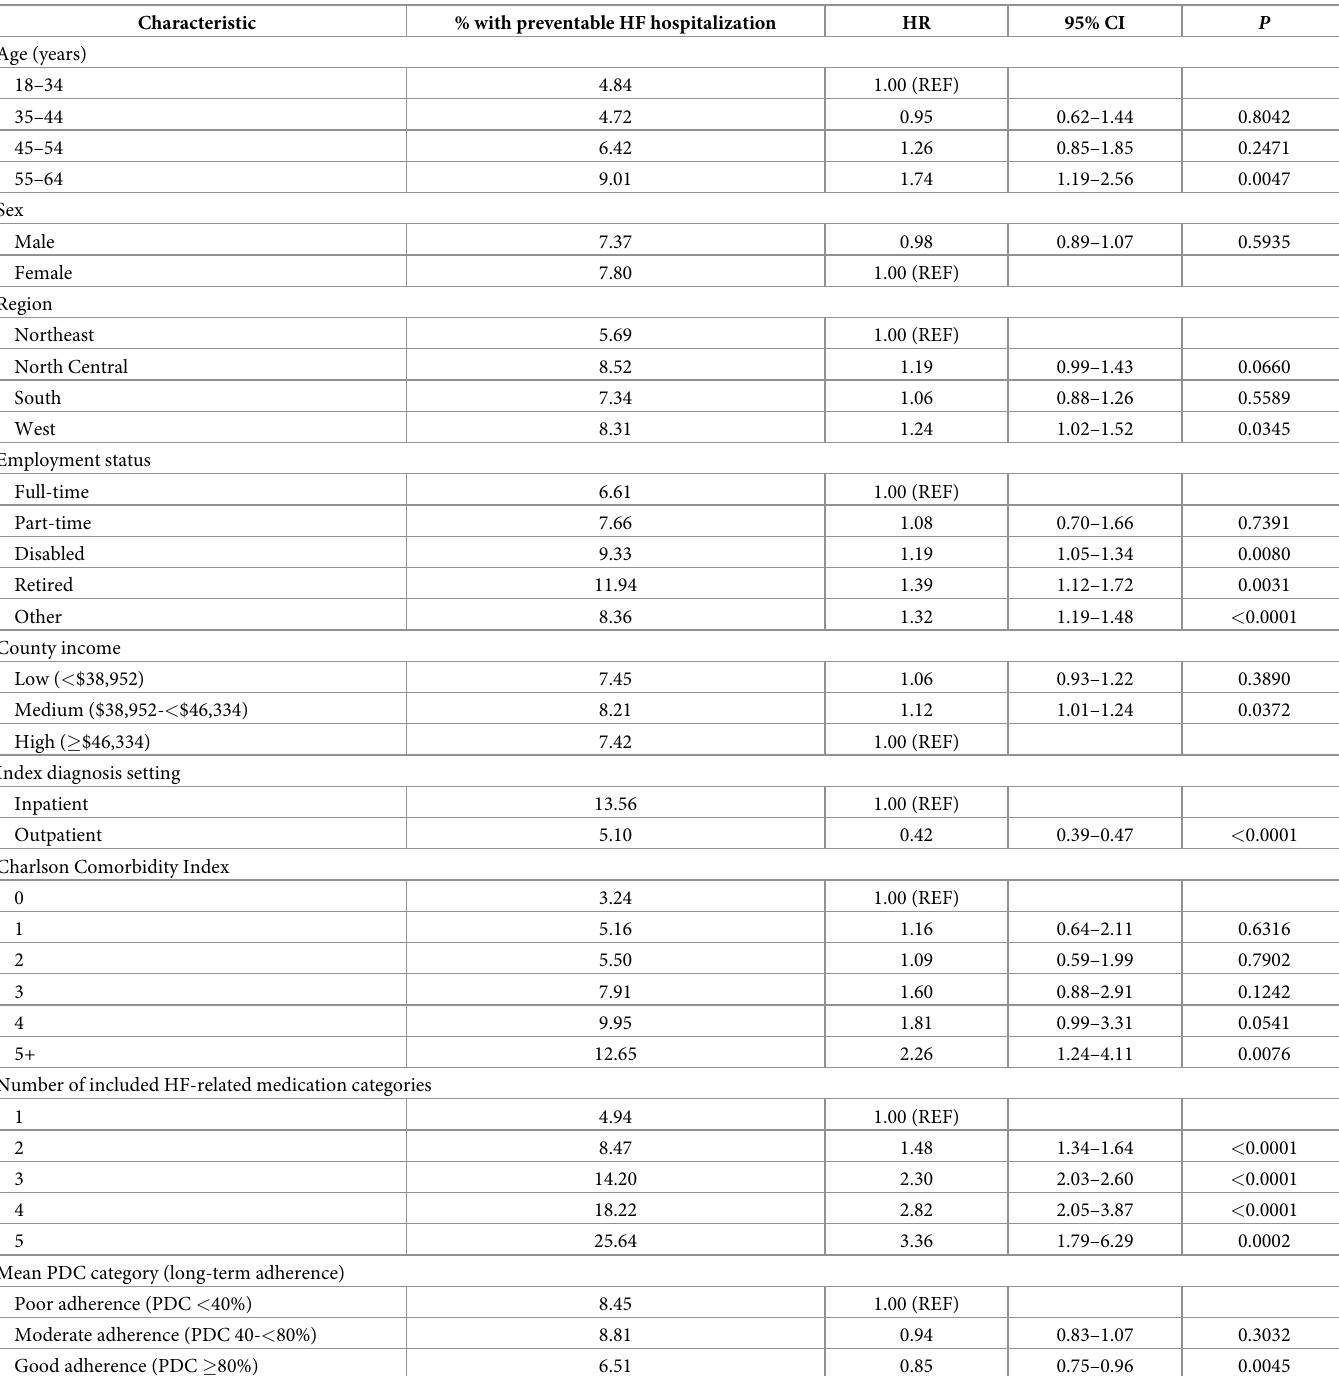
Table 3. Multivariate Cox proportional hazards model: Risk of preventable HF hospitalizations with full adjustment for baseline covariates (N = 26,439).